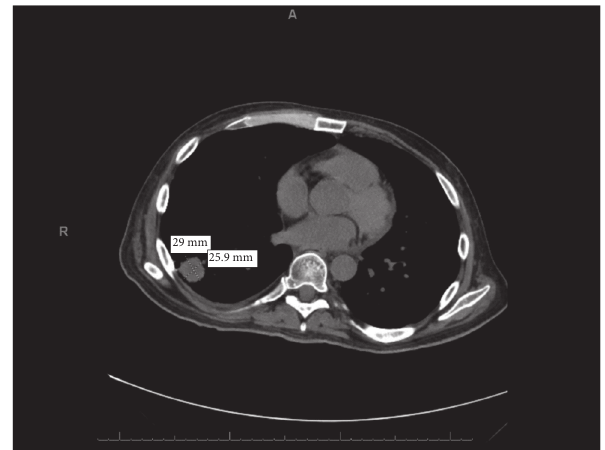
Figure 1: CTchest imaging showing increase in size of right lower lobe lung